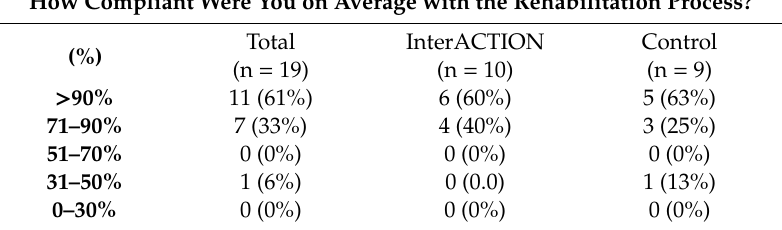
Table 3. Self-reported